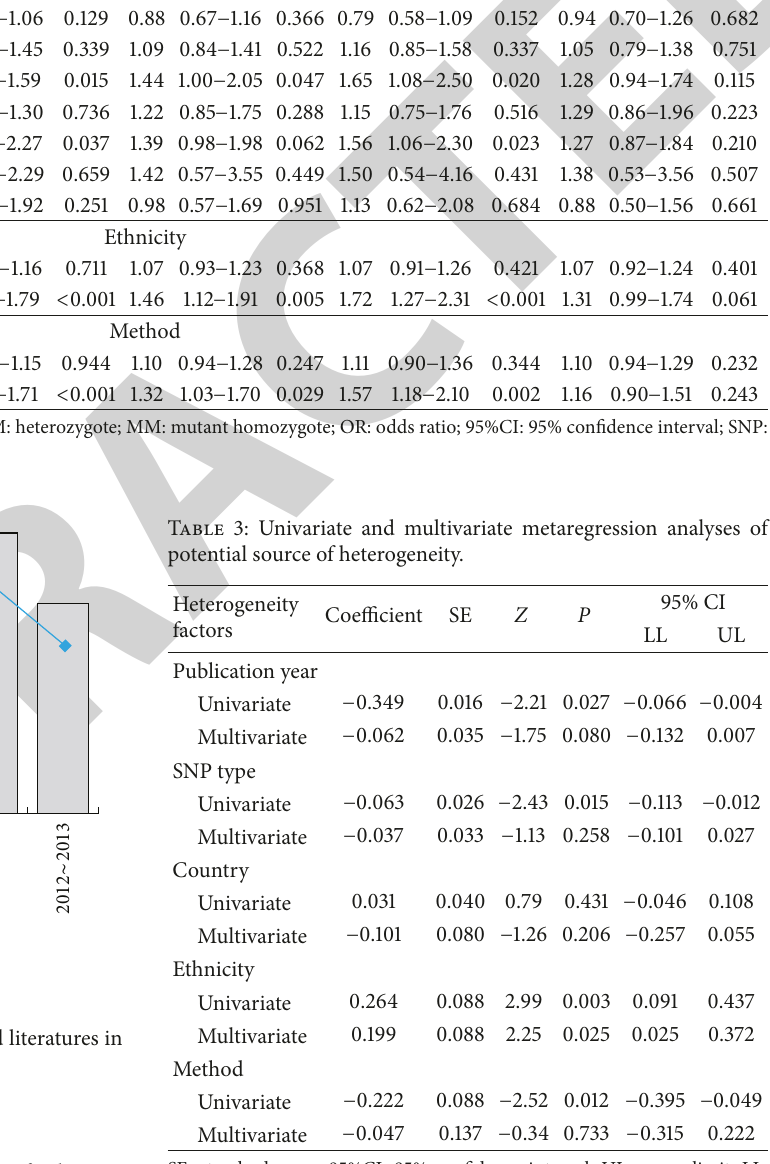
SE: standard error; 95%CI: 95% confidence interval; UL: upper limit; LL: lower limit; SNP: single nucleotide